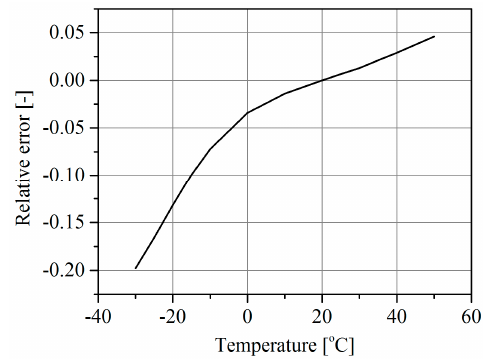
Figure 9. The weighing error in a WIM system equipped with piezoelectric polymer sensors, arising exclusively from a change in the sensor parameters due to a change in temperature (intrinsic error).